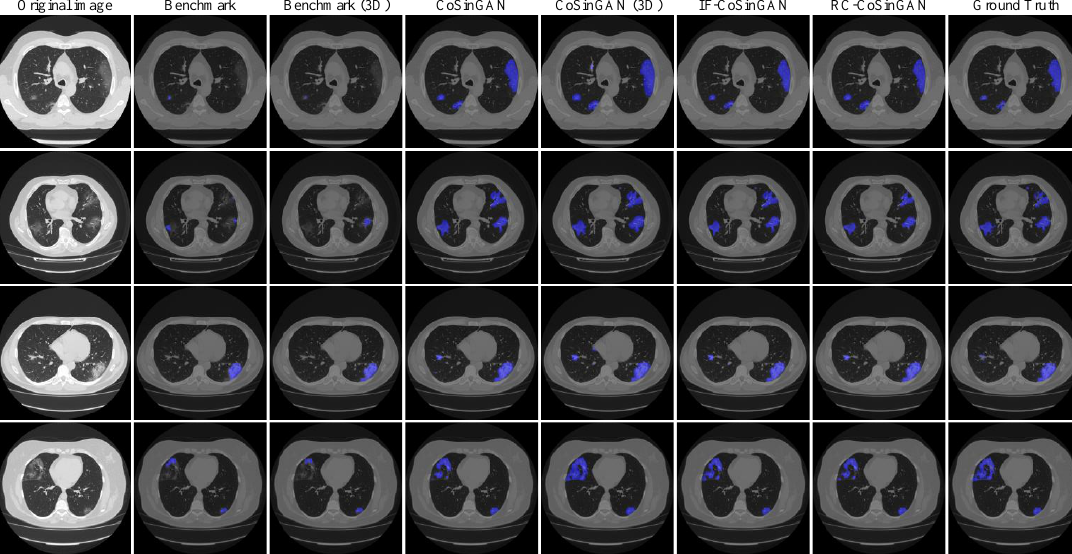
Figure 16. Visual comparison of infection segmentation results on the MosMed dataset, where the blue represents infected regions. Benchmark (3D) and CoSinGAN (3D) represent their results are based on 3D U-Net, whereas the others are all based on 2D U-Net. All results here come from the Fold-4. The blue denotes the infected